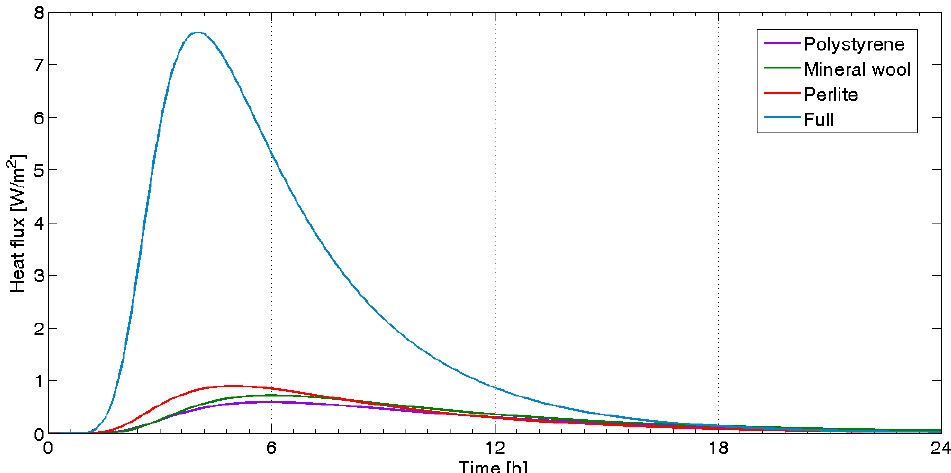
Figure 6. Heat flux vs. time for HWC blocks filled with different infill materials. Time lags and damping degrees for different combinations of clay density and insulating material as well as full blocks vs. front masses of the block are plotted in Figures 7 and 8, respectively. It is evident that front mass is not directly linked to time lag nor to decrement factor.